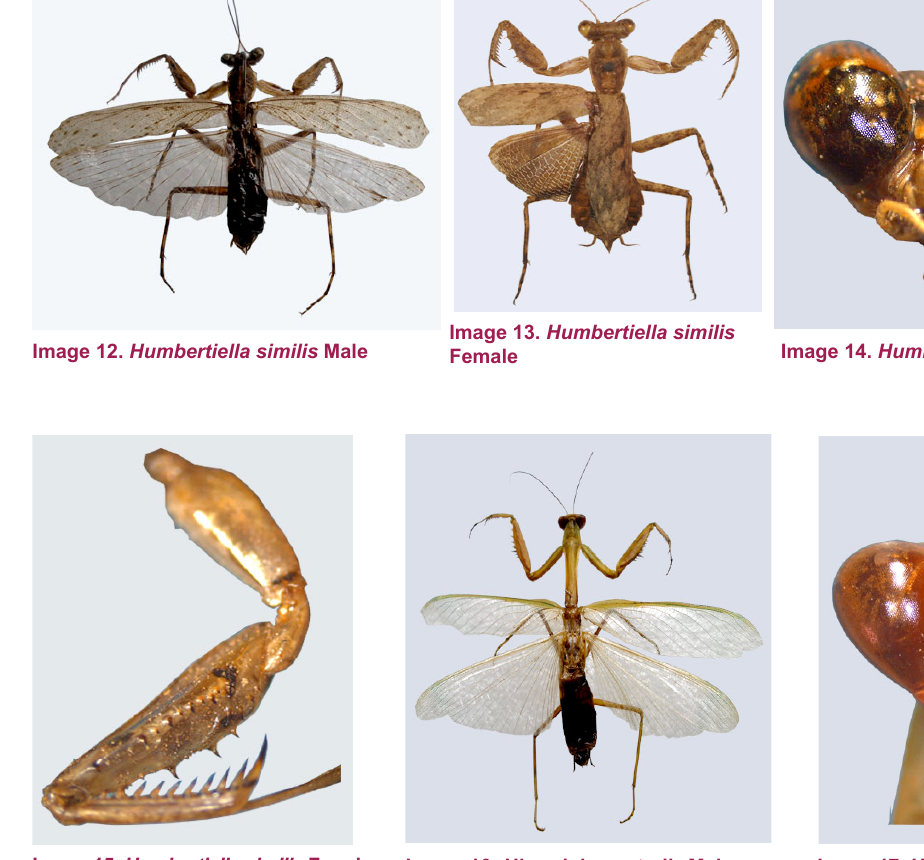
Diagnostic characters: Generally light green, head wider than high, vertex smooth, lateral lobes distinct; eyes globular, large, bulging; pronotum long; metazona 4.2x longer than prozona; fore coxa with six spinules; fore femur with four external spines, four discoidal spines and 15 internal spines, last two smaller spines closely placed, wings longer than the abdomen; fore wing semi hyaline; hind wing transparent. Measurements: Male: TL - 55mm, PN - 19mm, FW - 44mm.